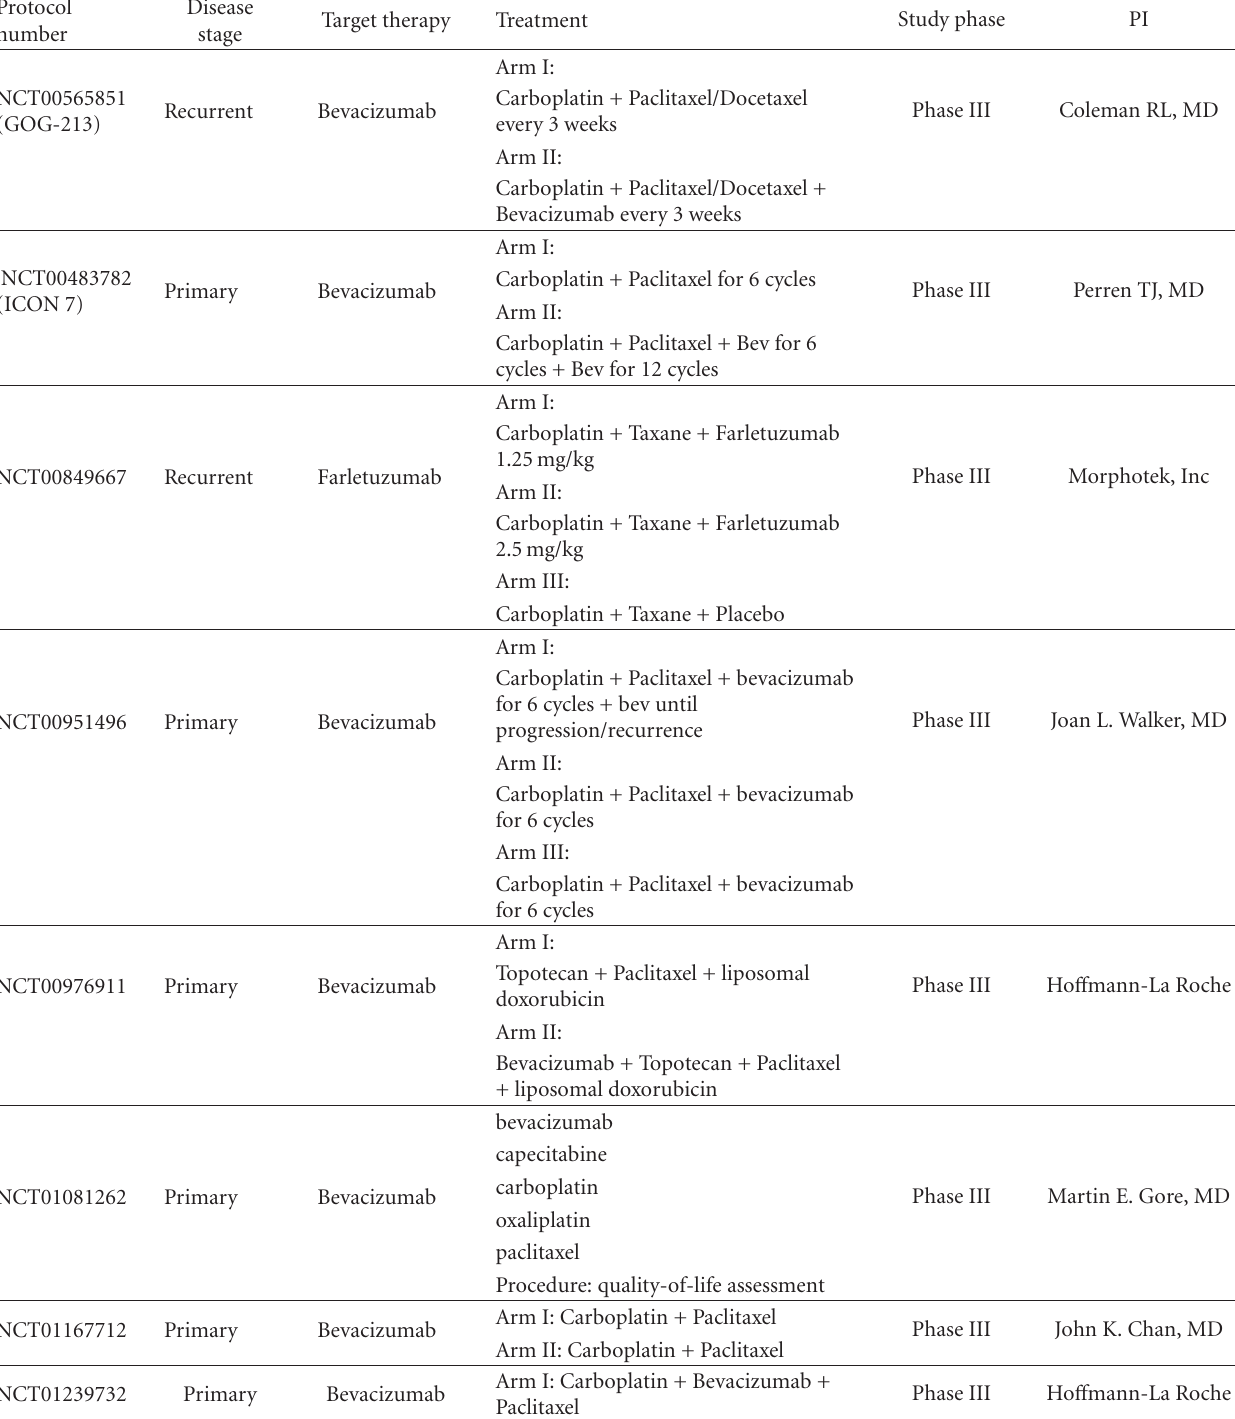
Table 2: Ongoing treatment studies evaluating MoAb treatment in ovarian cancer